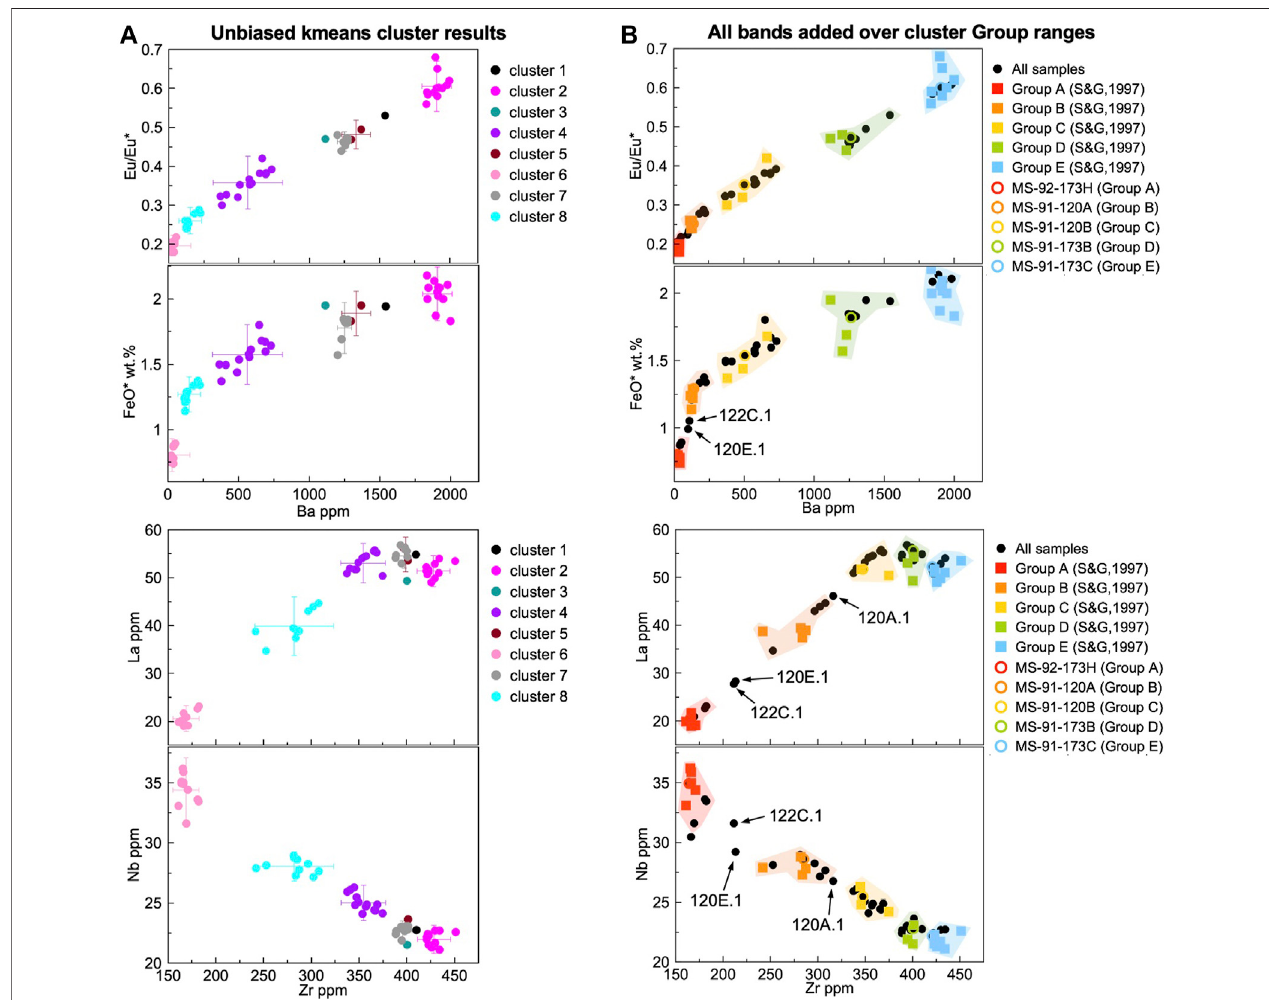
FIGURE5|(A) ResultsofkmeansclusteranalysisofRSThigh-silicarhyolites(HSRs)usingRStudiowhennumberofdesiredclustersinunde fi ned.Analysisplaced samples into eight clusters, where all samples originally postulated to be Group E were placed into cluster 2, Group D were placed into cluster 7, Group C were